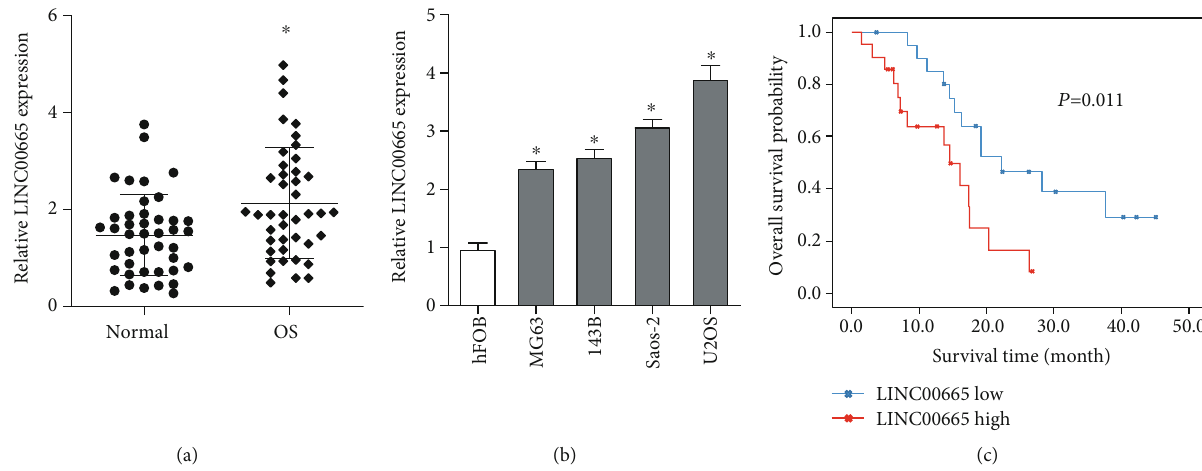
Figure 1: LINC00665 is upregulated in OS. (a) Expressions of LINC00665 in paired OS and nontumorous normal tissues were detected by qRT-PCR. (b) Expressions of LINC00665 in OS cell lines and normal osteoblast cell line were detected by qRT-PCR. (c) Overall survival of OS patients was analyzed by the Kaplan-Meier method. ∗ P < 0 : 05 . Table 1: Association between clinical feathers of OS patients and LINC00665 expression in OS tissues. Feathers